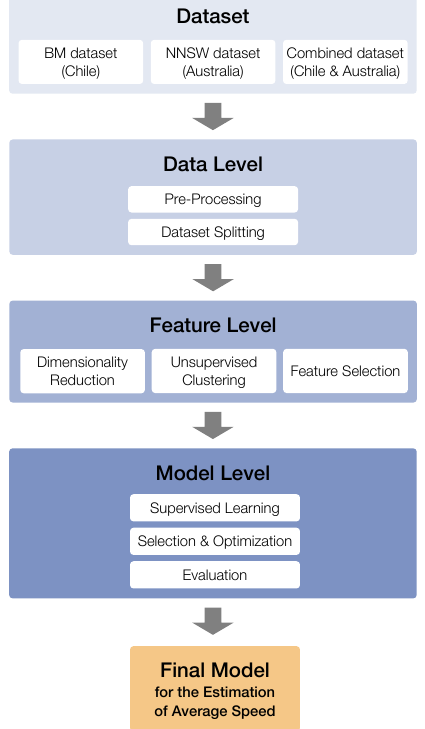
Figure 1. Estimation framework for the average speed estimation in road networks divided into dataset, the data level, the feature level, and the model level. Adopted from [28]. Table 1. Variable naming conventions of the input features extracted from or calculated from the OpenStreetMap (OSM) road network data. This naming is applied to the BM dataset (Chile), the NNSW dataset (Australia), and the combined dataset (Chile & Australia). The features are listed